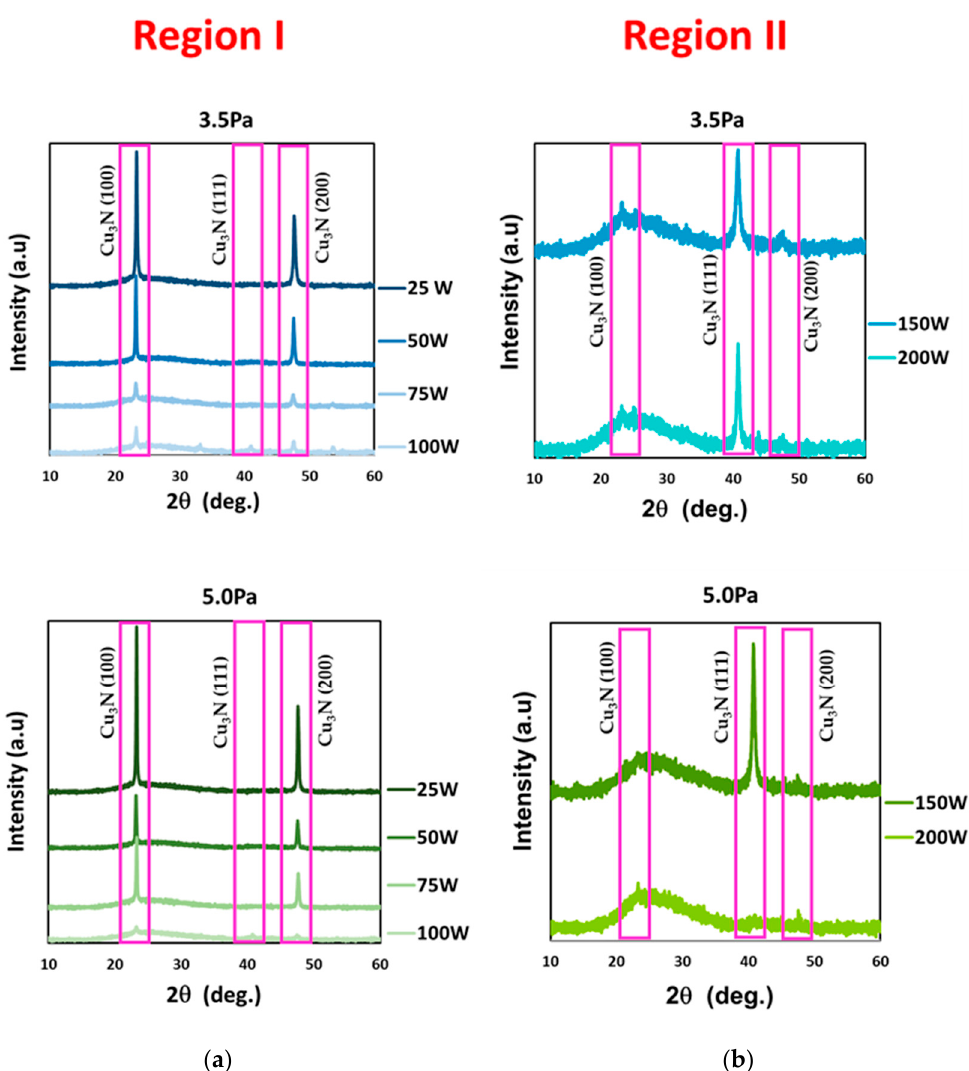
Figure 3. X-ray diffraction spectra of Cu 3 N films deposited at gas pressures of 3.5 Pa and 5.0 Pa and the different RF power of ( a ) 25 W to 100 W (region I) and ( b ) 150 W and 250 W (region II).